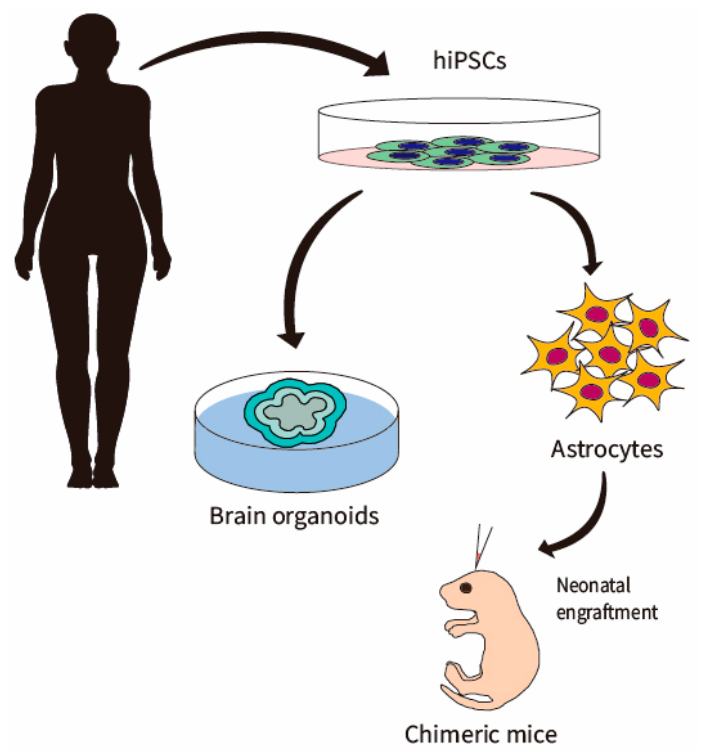
Figure 1. Generation of hiPSC-astrocytes. Astrocytes can be differentiated or directly converted from patient fibroblast-derived hiPSCs via 2D culture and 3D organoids. These astrocytes can be engrafted into mouse cortex to generate a chimeric mice